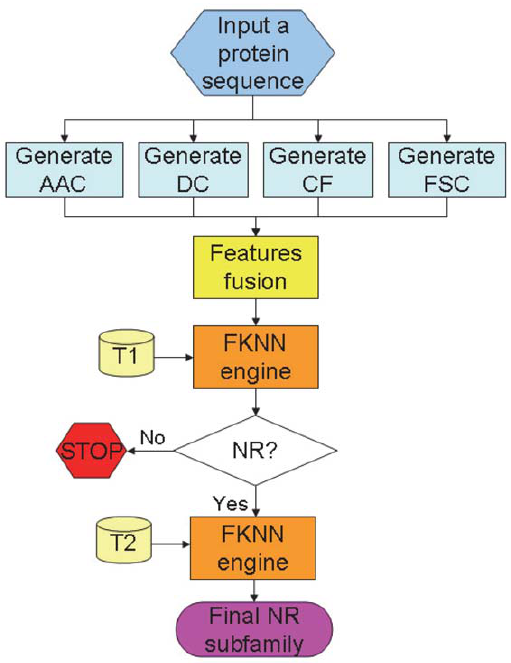
Figure 2. Flowchart to show the operation process of NR-2L. T1 represents the data taken from the Supporting Information S1 for training the 1st level prediction; T2 represents those from the Supporting Information S1 for training the 2nd level prediction. See the text for further explanation.